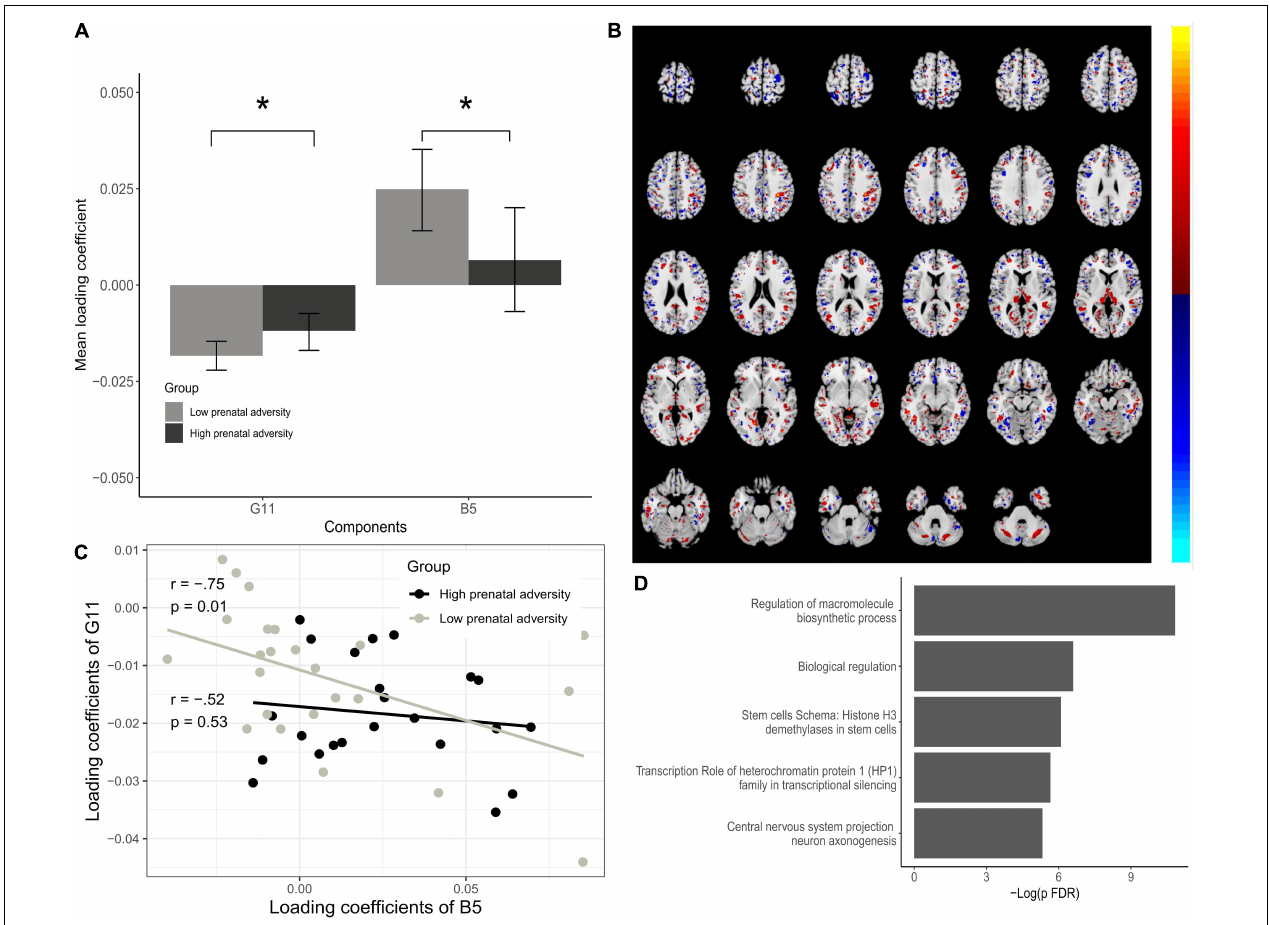
FIGURE 4 | Associations between Gene IC G11 and Brain IC B5. (A) Bar plots of estimated loading coefficients for statistically significant brain phenotype (B-5) and genetic component (G11) pair. (B) Brain areas comprising the B5 component according to group differences. (C) Scatter plot of loading coefficients of B5 and G11 and association between them for low and high prenatal adversity groups. Lines and dots colors represent the High and Low prenatal adversity score groups. (D) Enrichment analysis of G11 dominant SNPs. Loading coefficients represent the weight of the overall components for each subject. Significant differences in components are seen contrasting high and low adversity groups, indicating that individuals from high and low adversity groups contributed differently to the overall pattern of the component. * P <